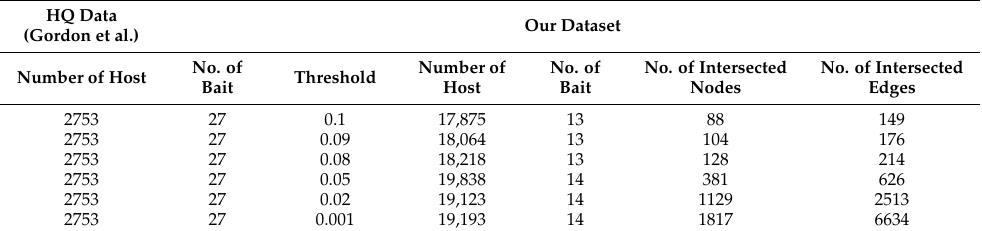
Table 6. Detailed validation of our model compared to High confidence human–nCoV proposed by Gordon et